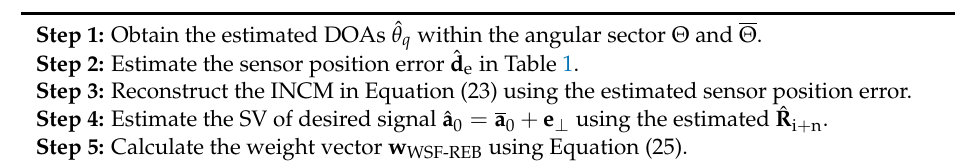
Table 2. Proposed WSF-REB